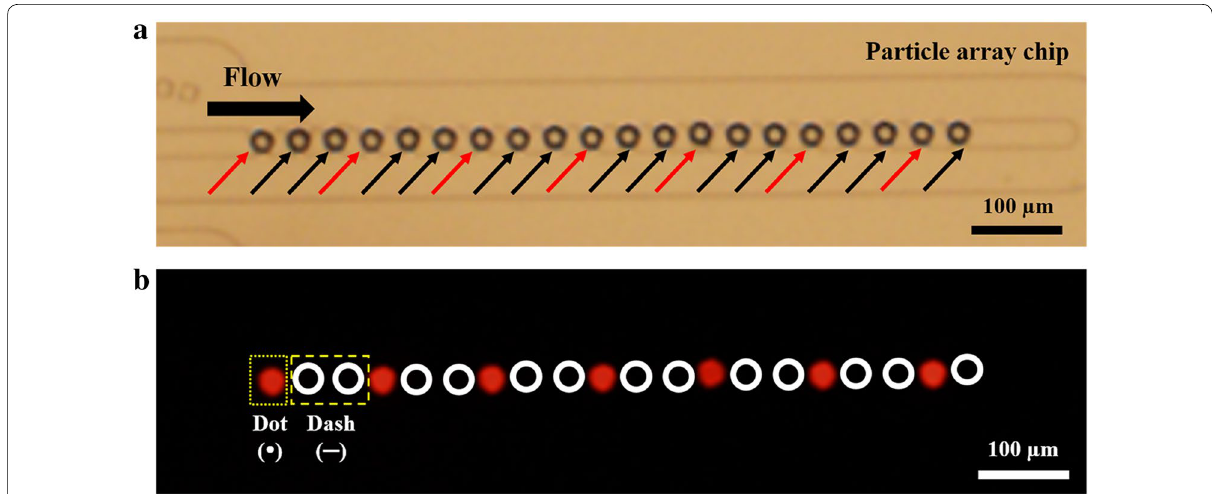
Fig. 3 1D linear pattern using two types of particles by repeating the “trapping-transfer-and-array” sequence. a Bright-field microscopic image of arrayed particles. Bare (indicated with black arrows) and red-fluorescent particles (indicated with red arrows) are deterministically trapped in an arraying device. b Fluorescent image revealing the linear pattern of the “dot-dash” line